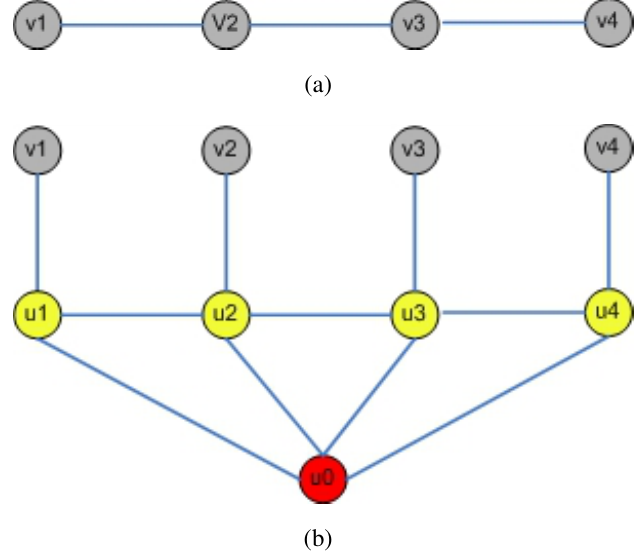
Figure 1. Example of: (a) Graph G ; (b) Transformed graph G (cid:48)